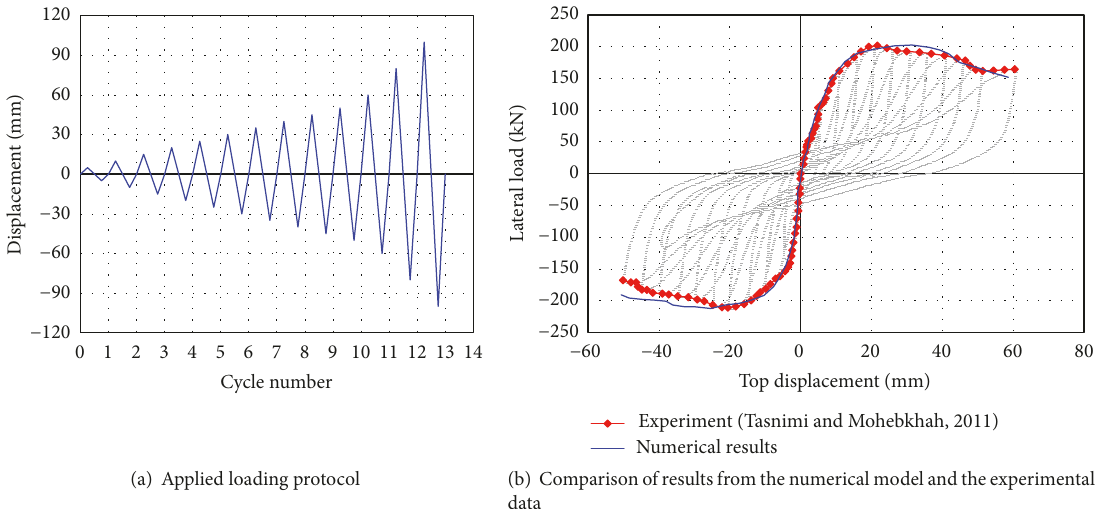
Figure 6: Specimen SW tested by Tasnimi and Mohebkhah [16].